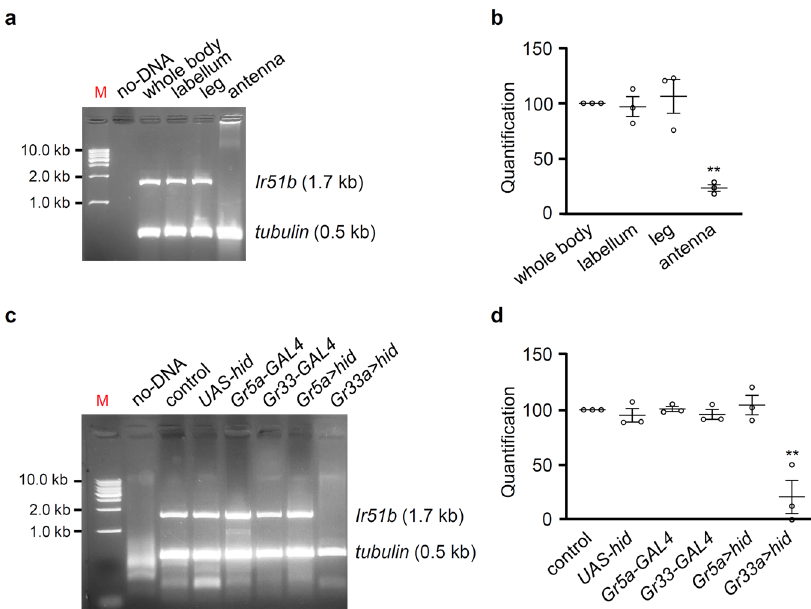
Fig. 4 Ir51b is expressed in bitter-sensing GRNs on the labellum. a Gel picture of RT-PCR results showing Ir51b expression in the labellum and legs, but not in the antennae. Ampli fi ed tubulin products were used as control. “ M ” indicates the DNA ladder marker. b Quanti fi cation of Ir51b RNA levels which was normalized by tubulin in the same reaction in panel ( a ). The density of Ir51b RNA was divided by tubulin RNA level in each batch and control (whole body) was set to 100 by same fold change in the batch. Three repeated experiments were provided. c Gel picture of Ir51b expressed in bitter-sensing GRNs. The 1.7 kb Ir51b gene was ampli fi ed using RT-PCR in no-DNA template, the control ( w 1118 ), UAS-hid , Gr5a-GAL4 (sugar-sensing GRNs), Gr33a-GAL4 (bitter- sensing GRNs), Gr5a - GAL4 / UAS - hid (sugar-sensing GRNs ablated), and Gr33a - GAL4 / UAS - hid (bitter-sensing GRNs ablated) fl ies. Ampli fi ed tubulin products were used as internal control of PCR reaction. “ M ” indicates the DNA ladder marker. d Quanti fi cation of Ir51b RNA levels which was normalized by tubulin in the same reaction in panel ( c ). Three repeated experiments were provided. The density of Ir51b RNA was divided by tubulin RNA level in each batch and control ( w 1118 ) was set to 100 by same fold change in the batch. All error bars represent the SEMs. Multiple comparisons were conducted using single-factor ANOVA coupled with Scheffe ’ s post hoc test. The asterisks indicate statistical signi fi cance, compared to the control (whole-body sample in ( b ) and control in ( d )) ( ** P <